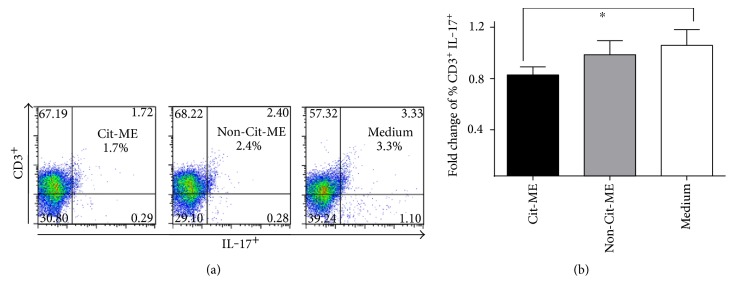
Cit-ME downregulated Th17 cells in vitro. (a) Representative plots of CD3 and IL-17 staining. Positive staining is presented in the right upper quadrant of each plot with the percentage indicated. (b) Fold change of % CD3+ IL-17+ T cells (n = 11). Data are presented as mean values (∗p = 0.05).